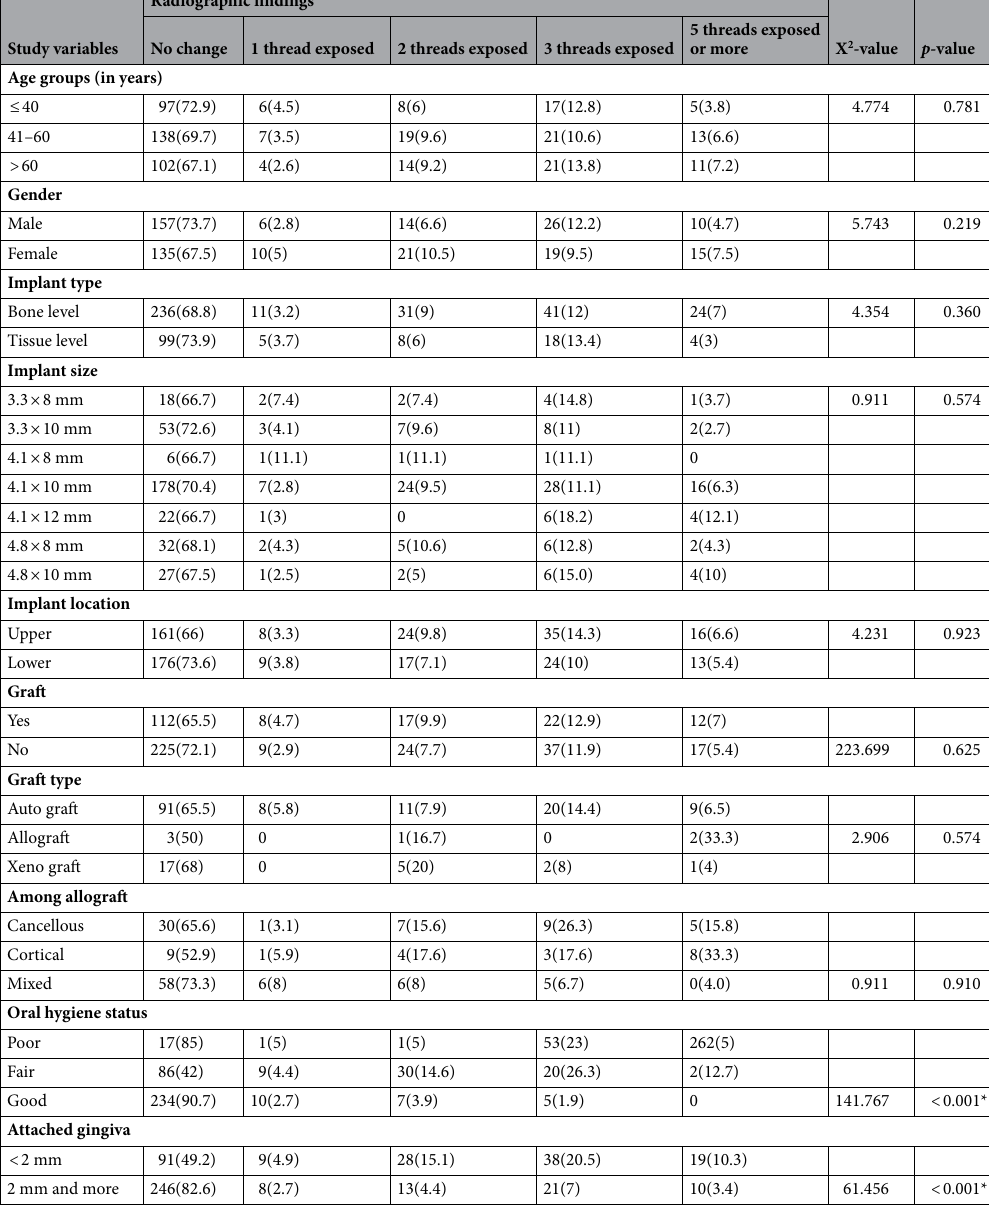
Table 6. Association between radiographic findings and other study variables. *Statistically